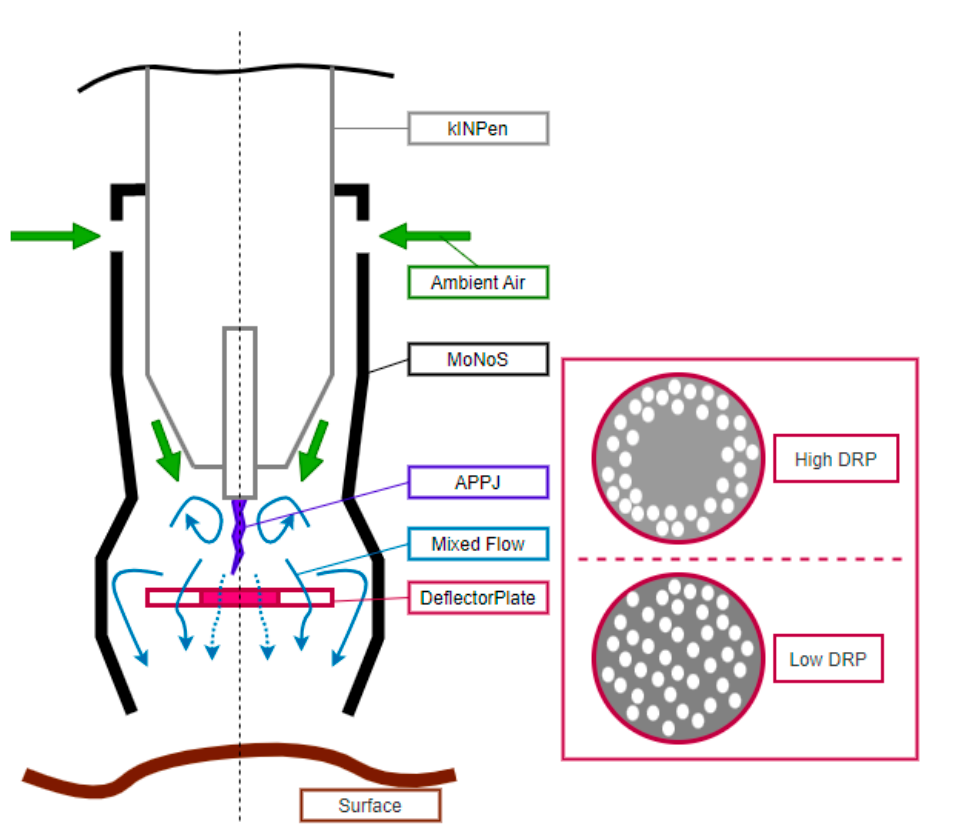
Figure 1. Half-section of an exemplary MoNoS adapter (black) surrounding the kINPen (gray). The argon APPJ (effluent indicated in purple) drives a pressure gradient that sucks in ambient air (green arrow, indicating flow direction) at a constant rate, stabilizing the air-plasma ratio at the mixing zone (blue swirl arrow) around the effluent, and, thus, ROS production. A porous deflector plate is used for dynamic pressure reduction (DPR) of the jet. The amount of pressure reduction is controlled by the porosity of the plate. Two versions were used: a partially perforated (high DPR) disk with a fully solid center region (no dotted arrow center outflow) and a fully perforated (low DPR) disk (outflow includes dotted arrows). This results in a homogenized, settled, and mixed outflow (blue arrows) with a strongly reduced axial flow momentum onto the treated surface (brown).